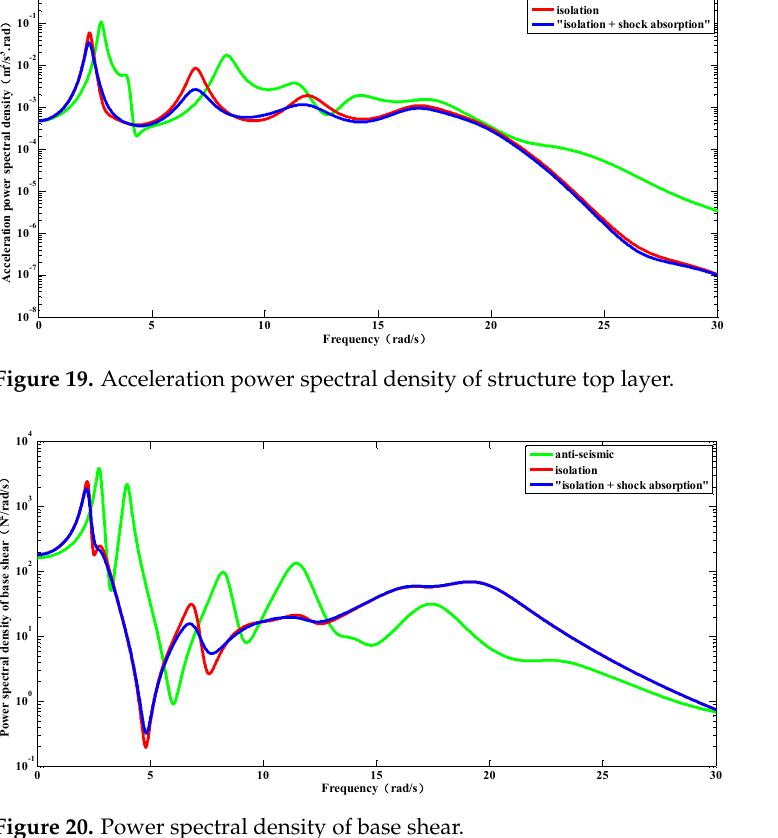
Figure 20. Power spectral density of base shear.